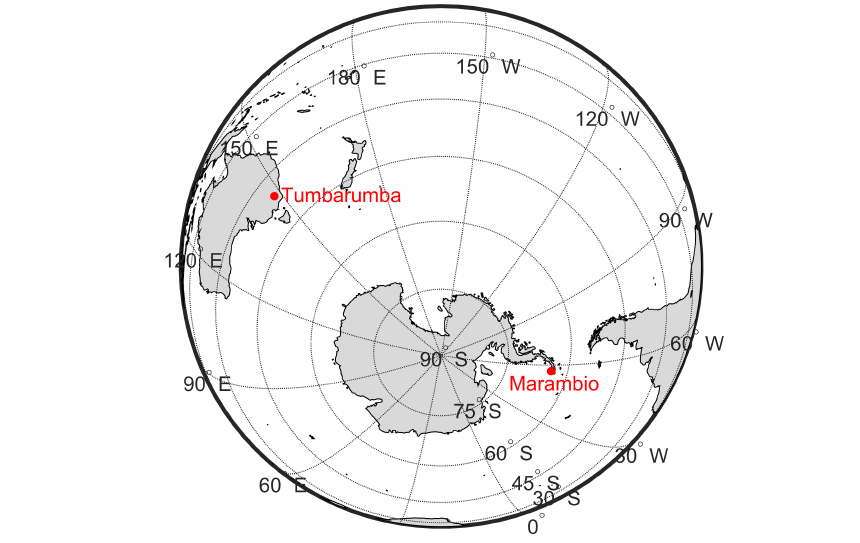
Figure 1. Location of the Marambio station (Antarctica) and Tumbarumba AERONET station